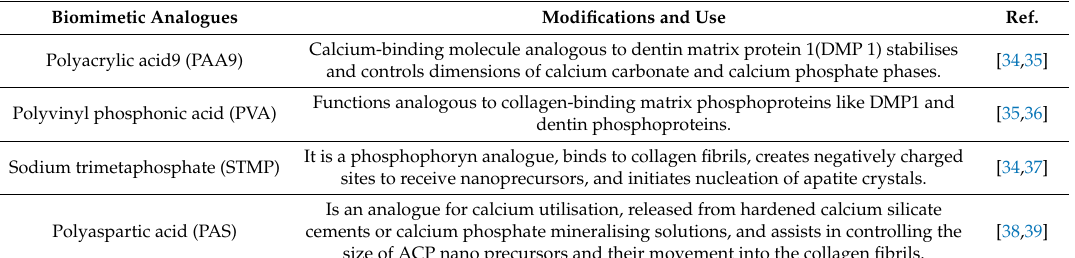
Table 2. Biomimetic analogues for dentin remineralisation.